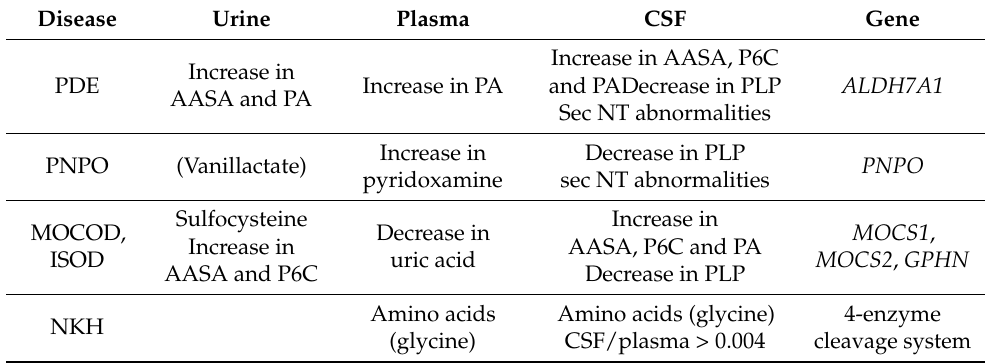
Table 2. Metabolic and genetic biomarkers